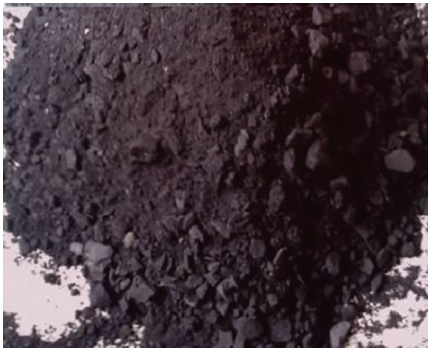
Figure 3: Appearance of oil shale semicoke used in this paper.